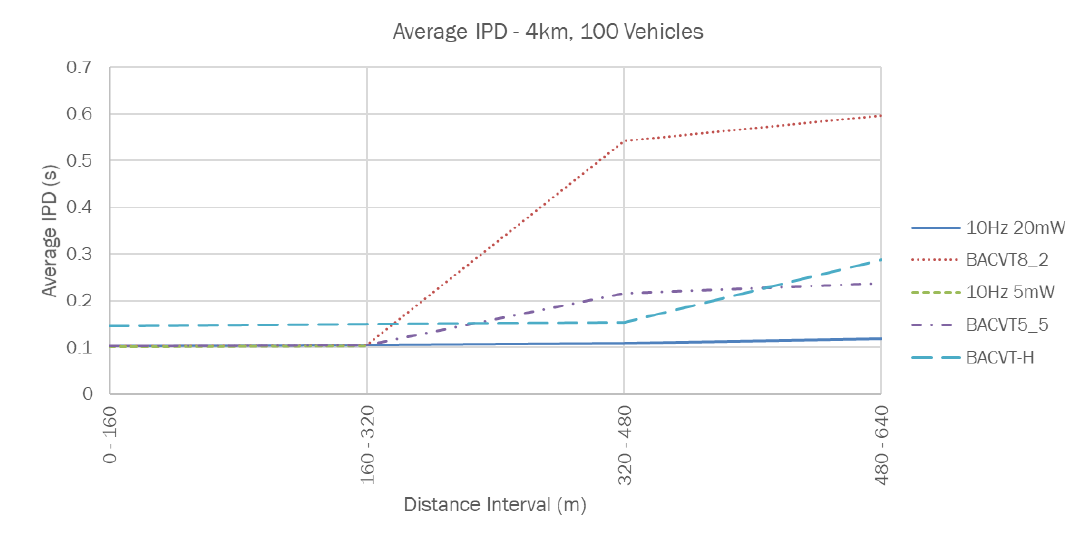
Figure 7. IPD in low vehicle